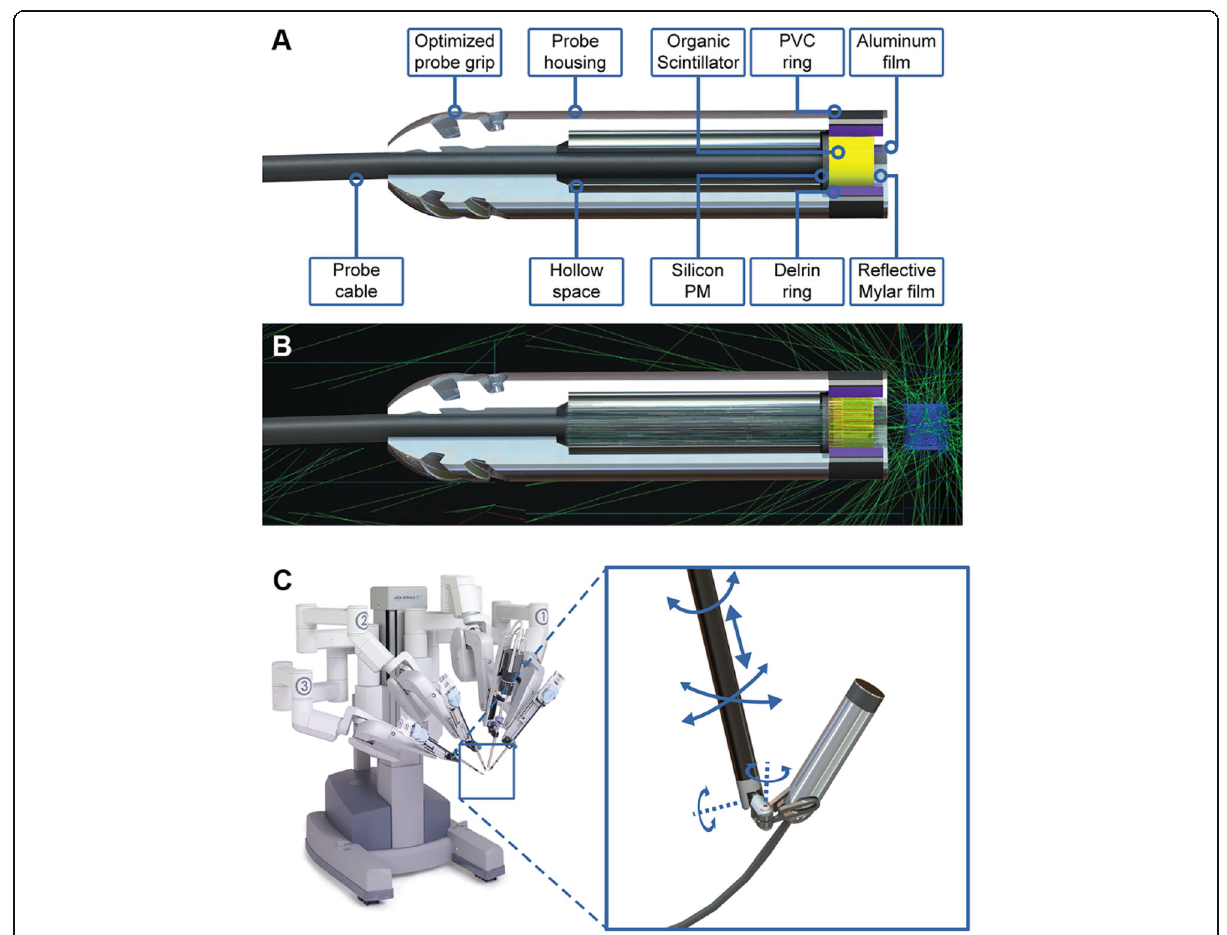
Fig. 1 DROP-IN β probe design. a Schematic representation of the probe components. b Example of one of the Monte Carlo simulations optimizing β -particle detection and γ -photon transparency. c Overview of the probe application setup, showing its high